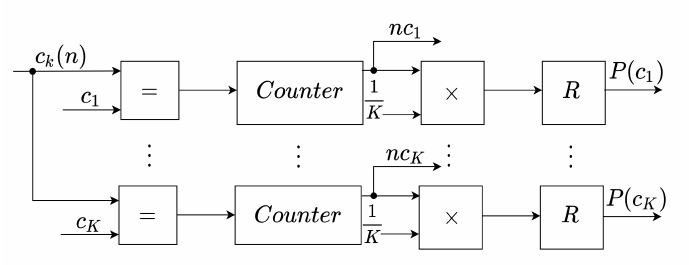
Figure 4. CPM module internal